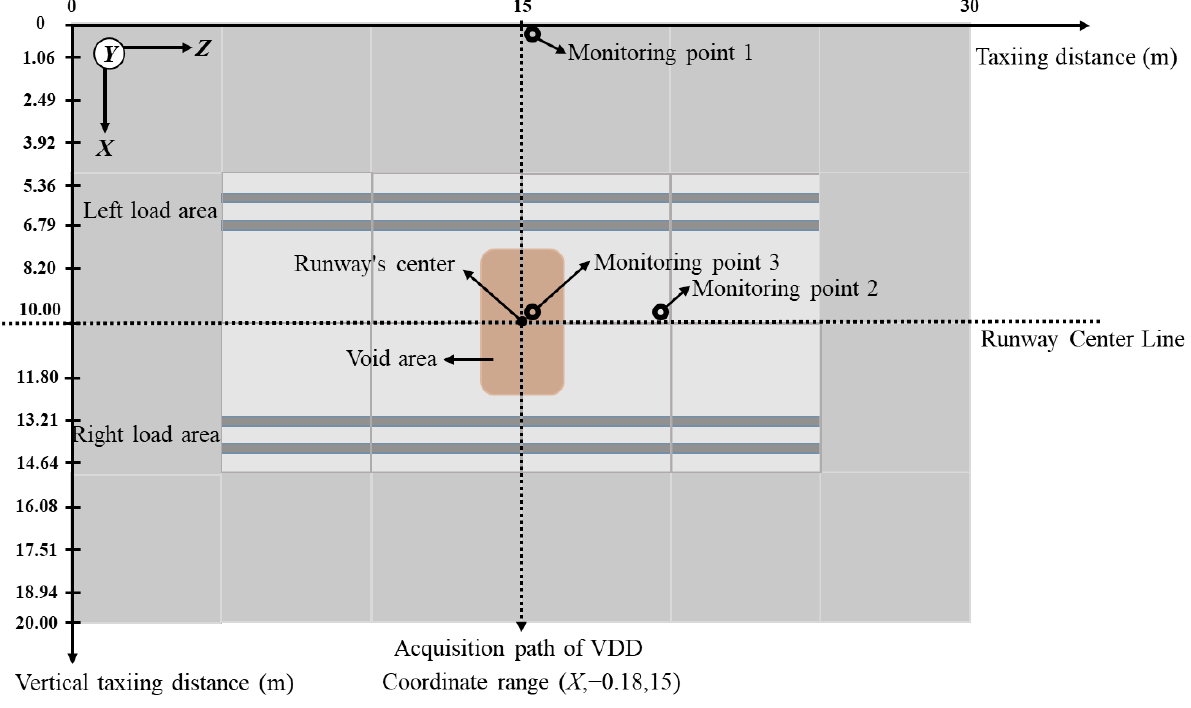
Figure 8. Acquisition path of VDD and vibration signal monitor points.